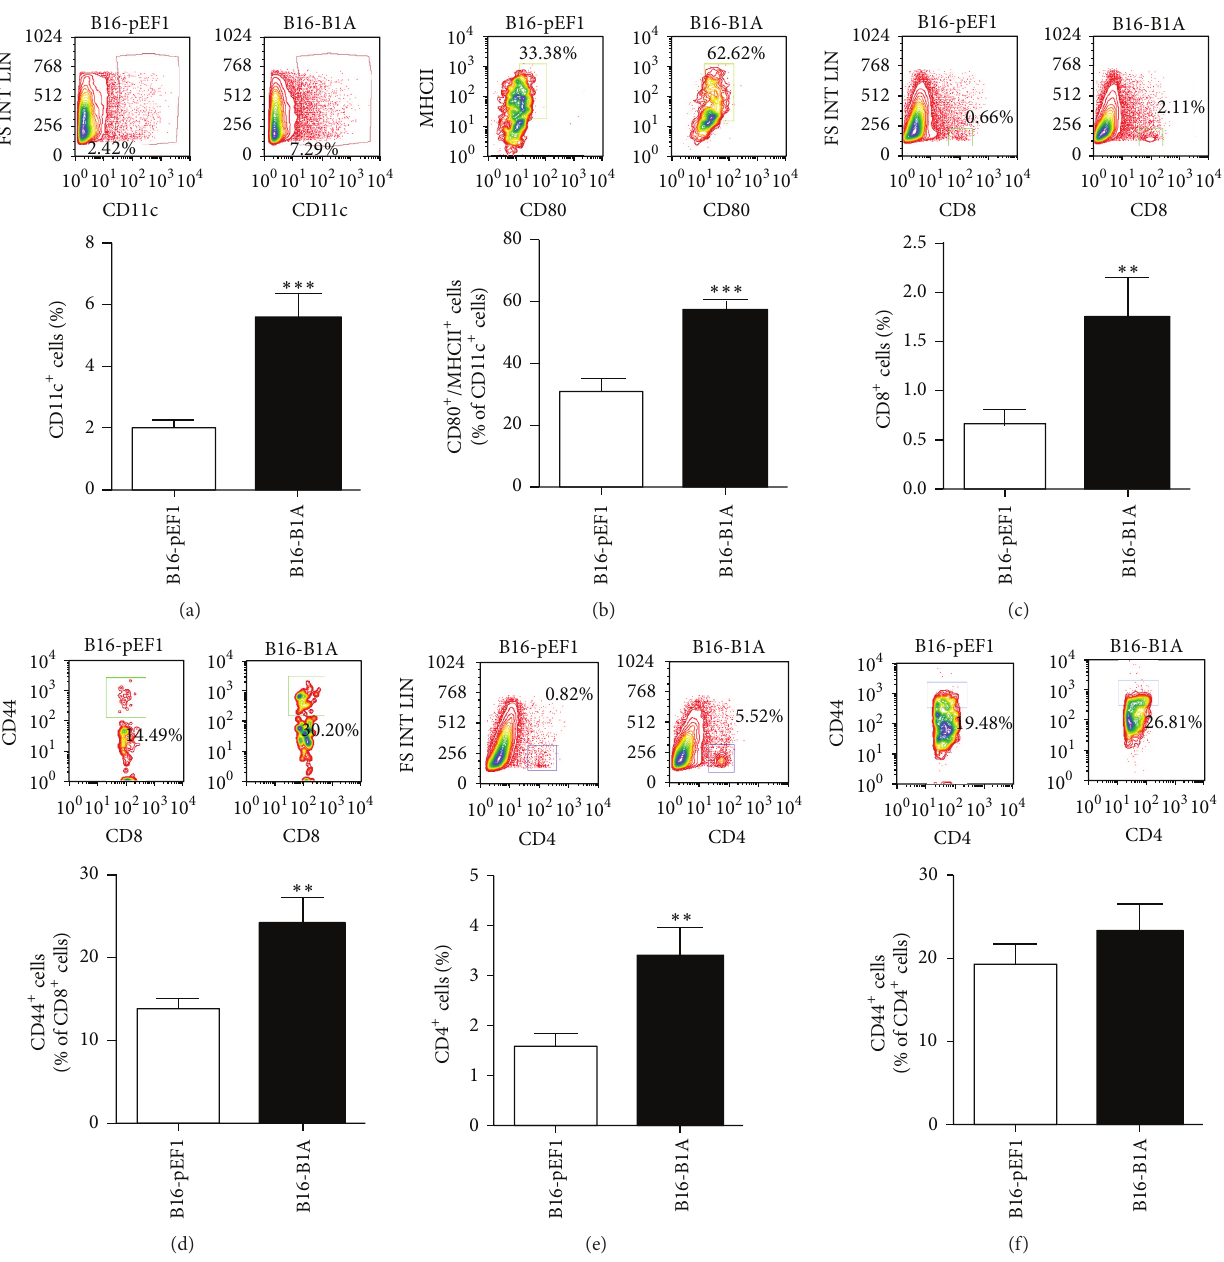
Figure 5: A-SMase expression increases the recruitment of effector antitumoural immune cells. Flow cytometry analysis of tumour- infiltrating immune cells. Tumour cell suspensions obtained from resected tumours were stained with the specific fluorescent conjugated antibodies for CD11c, CD80, MHCII, CD8, CD4, and CD44 antibodies. (a) A representative dot plot of gated CD11c + cells is shown ( upper panel ). The histograms represent the data obtained from ten to fifteen animals per experimental group ( lower panel ). (b) A representative dot plot of CD80 + /MHCII + cells in the CD11c + cell population is shown ( upper panel ). The histograms represent the data obtained from ten to fifteen animals per experimental group ( lower panel ). (c) A representative dot plot of CD8 + cells is shown ( upper panel ). The histograms represent the data obtained from ten to fifteen animals per experimental group ( lower panel ). (d) A representative dot plot of CD8 + /CD44 + in the CD8 + cell population is shown ( upper panel ). The histograms represent the data obtained from ten to fifteen animals per experimental group ( lower panel ). (e) A representative dot plot of CD4 + cells is shown ( upper panel ). (f) A representative dot plot of CD4 + /CD44 + in the CD4 + cell population is shown ( upper panel ). The histograms represent the data obtained from ten to fifteen animals per experimental group ( lower panel ). Values in each histogram are expressed as mean ± SEM. ∗ 𝑃 < 0.05 ; ∗∗ 𝑃 < 0.01 versus B16-pEF1